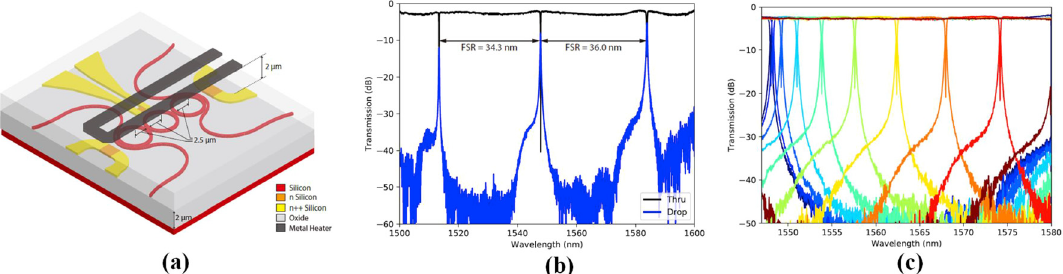
Figure 19: (a) Illustration of a photoconductive heater integrated into the MRR; (b) measured drop-port transmission (left axis) and photocurrent from the photoconductive heater (right axis) of the ring as a function of the supplied electrical power to the heater [234]. MRR, microring